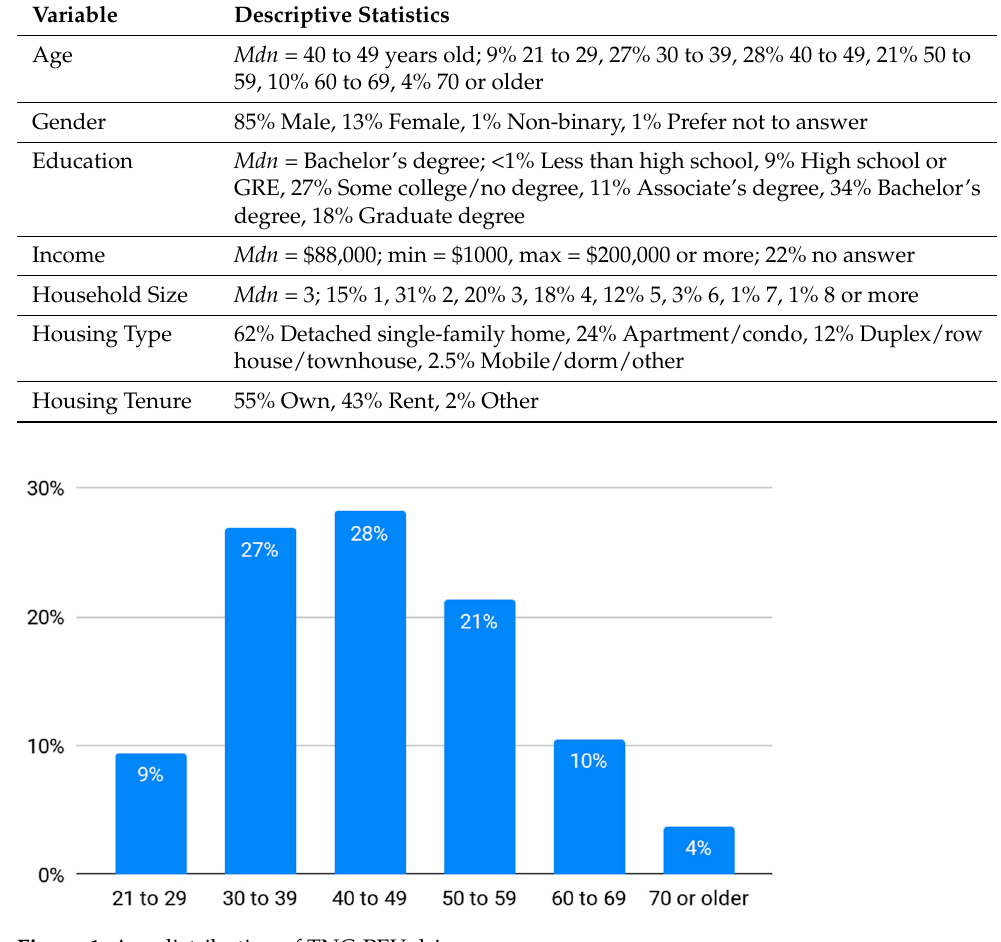
Figure 1. Age distribution of TNC-PEV drivers.